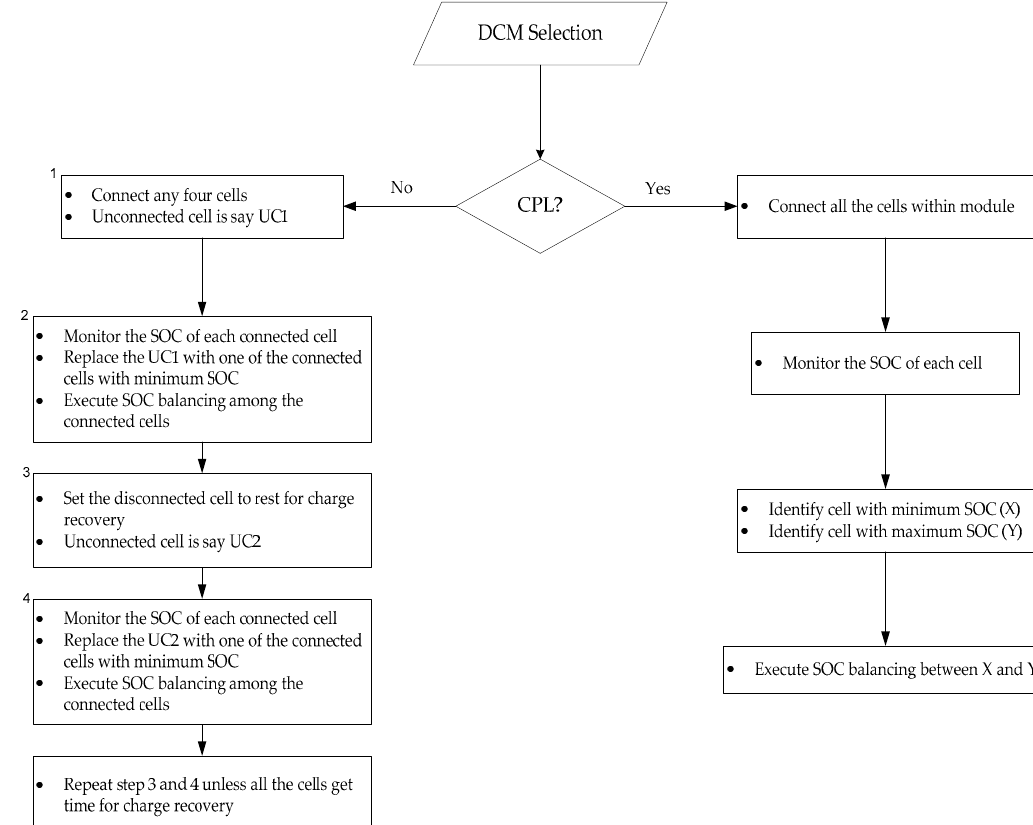
Figure 22. Operational process flow for battery management system (BMS).